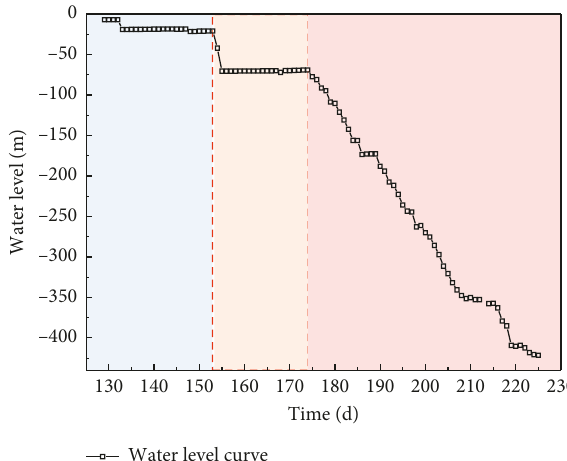
Figure 15: Variation of the water level with time in the drainage process.